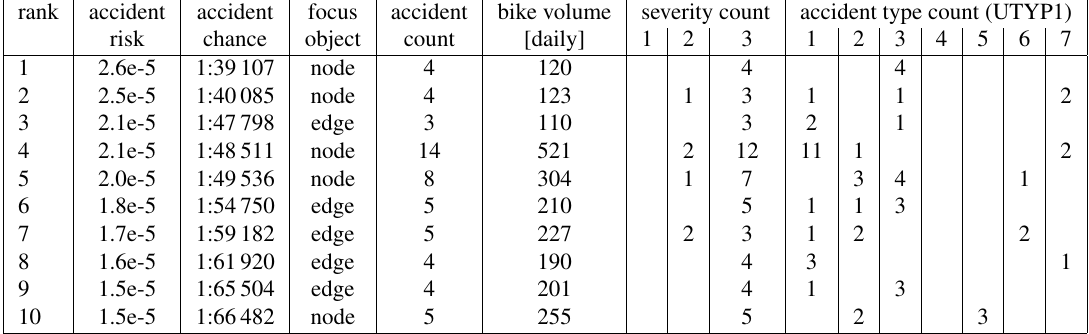
Table 2. Listing of the spots with ten highest risk scores, the respective chance and their key indicators. Focus object indicates whether the focus is at an intersection or on the road. The severity goes from dead (1) to slightly injured (3). The accident types are driving accident (1), turning accident (2), entering/crossing accident (3), passing accident (4), accident by stationary traffic (5), longitudinal traffic accident (6) and other (7). Their locations are marked in figure